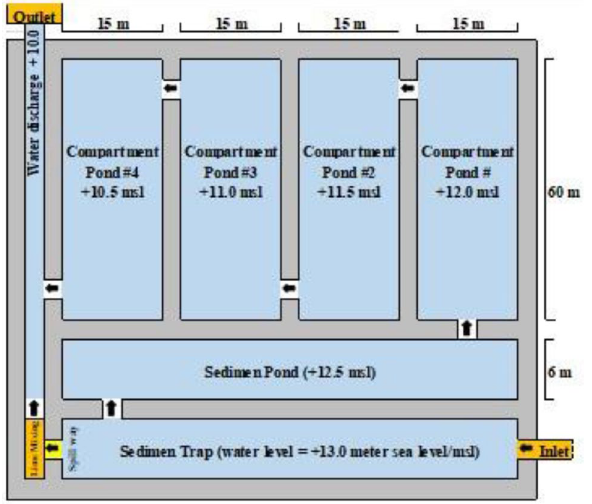
Figure 6. Layout design for construction swampy forest system referenced by basic data of laboratory simulation